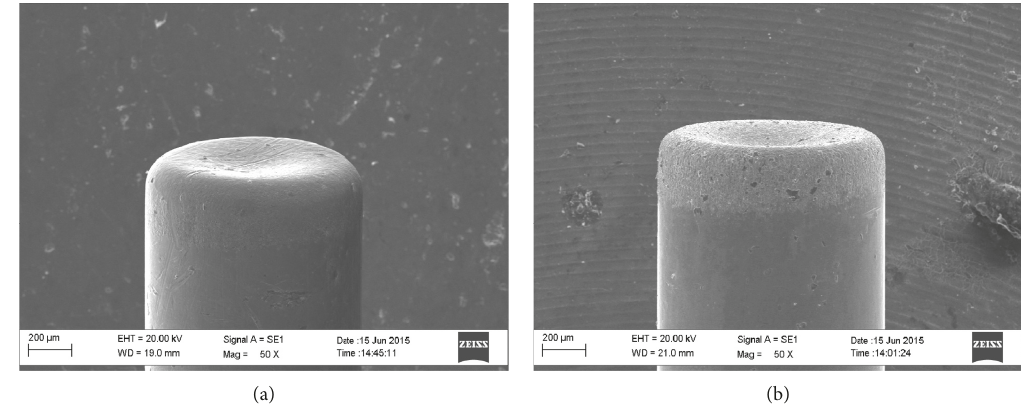
Figure 14: Electrode shape change with different electrode materials (no. 7 of Table 1). (a) Copper electrode. (b) Tungsten electrode.